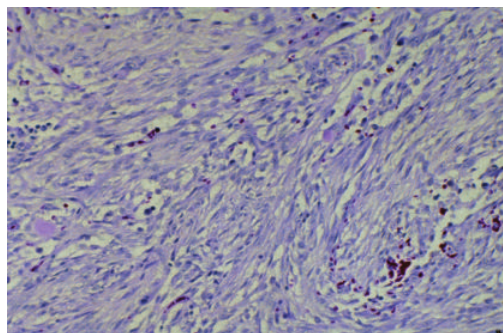
Figure 2: CT scan of right orbital rim mass.